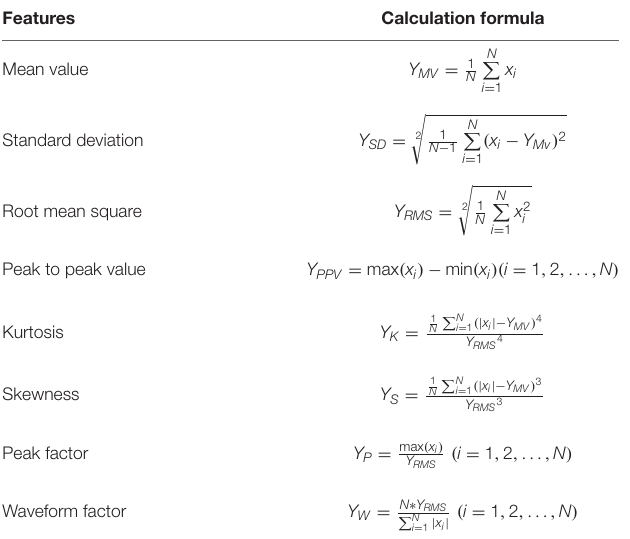
TABLE 2 | The extracted time domain features of the Romberg’s test data. Features